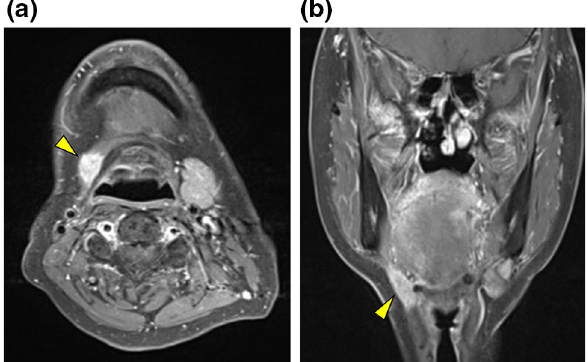
Figure 3. Imaging of lateral lingual lymph node metastasis (LLNM) in the parahyoid area. Lateral LLNM (arrowhead) is demonstrated in the parahyoid area on the right side on ( a ) enhanced axial T1-weighted magnetic resonance (MR) and ( b ) enhanced coronal T1-weighted MR